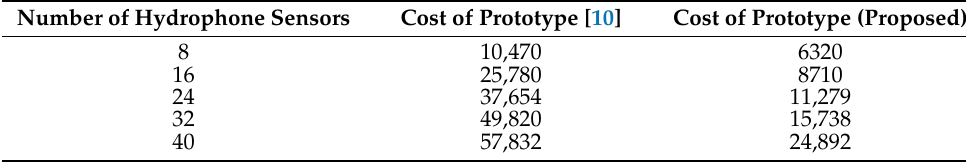
Table 6. Implementation cost.